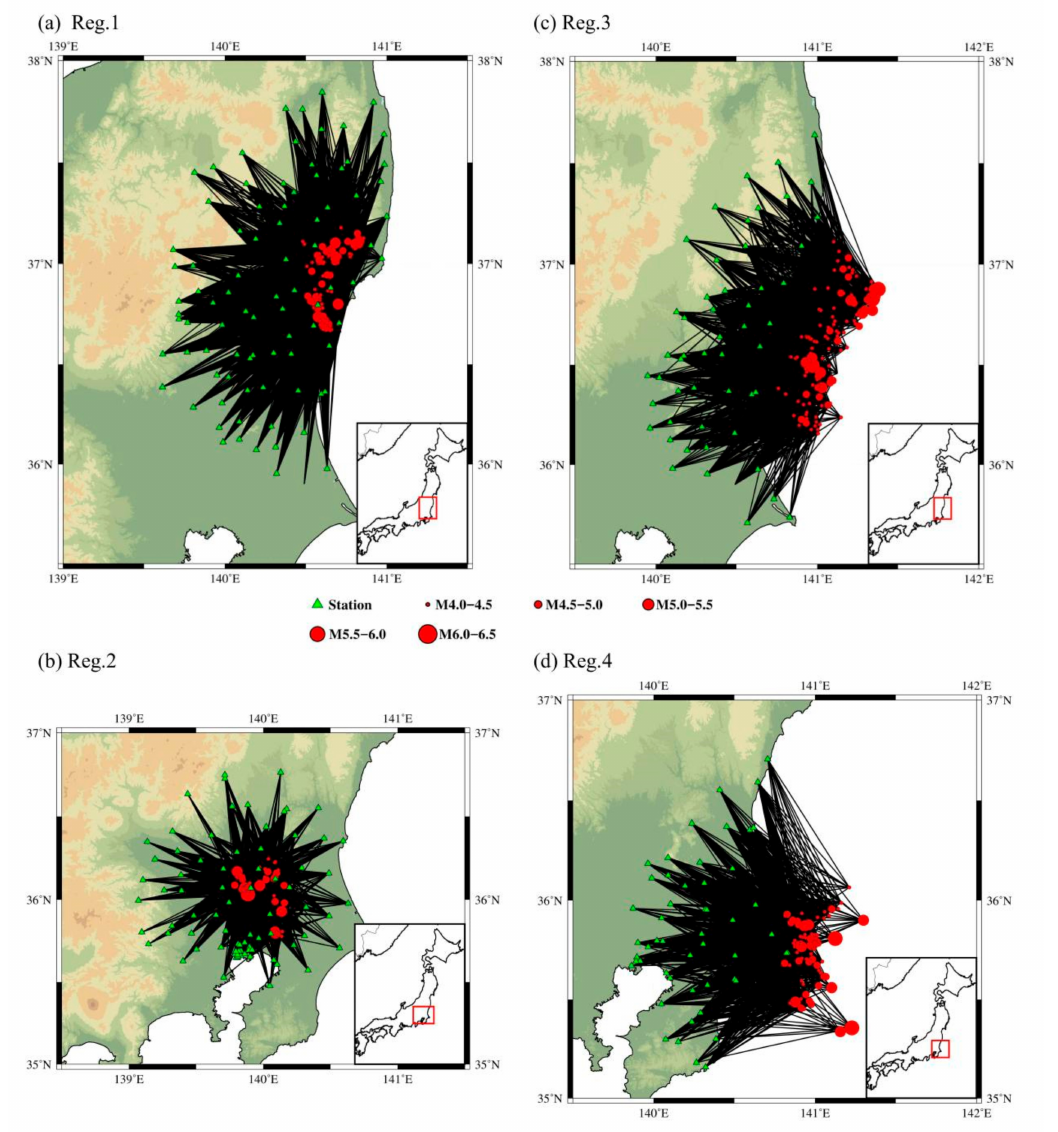
Figure 5. Earthquake epicentres (circles) and strong–motion stations (triangles) considered